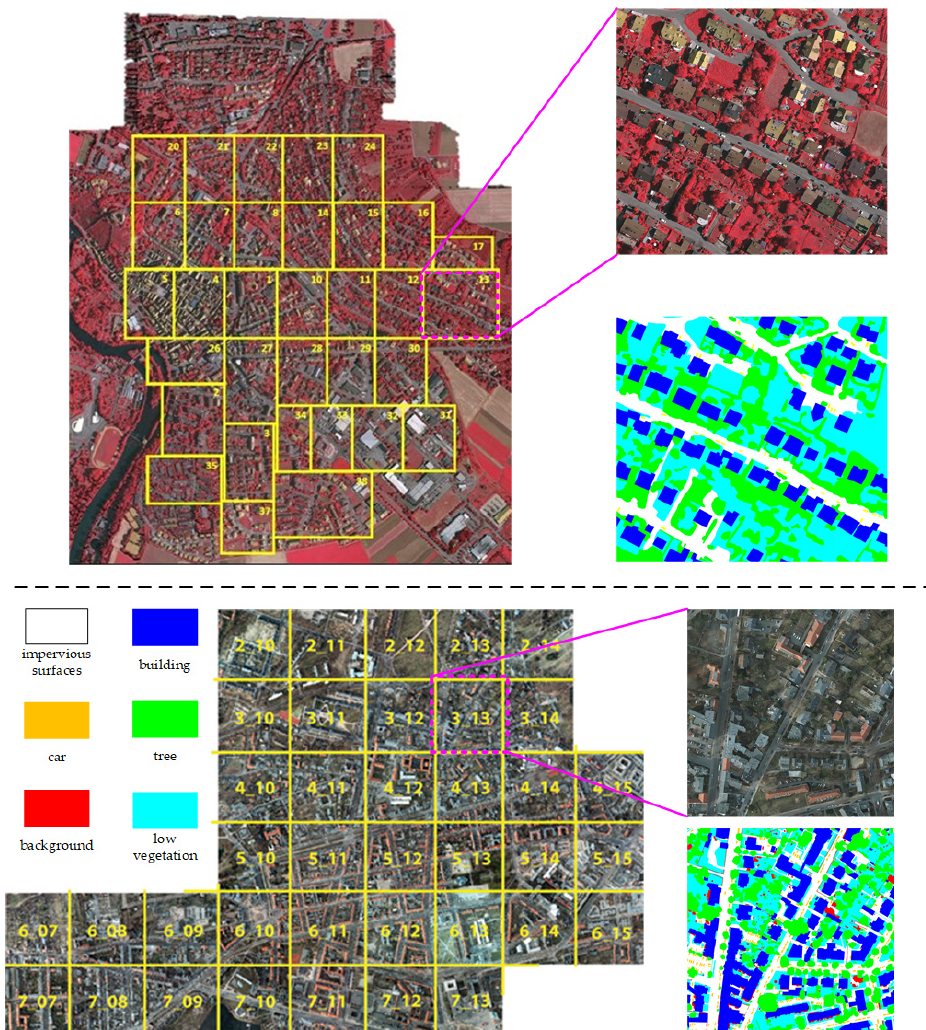
Figure 7. Example images and labels from the ISPRS Vaihingen dataset ( top part) and Potsdam dataset ( bottom